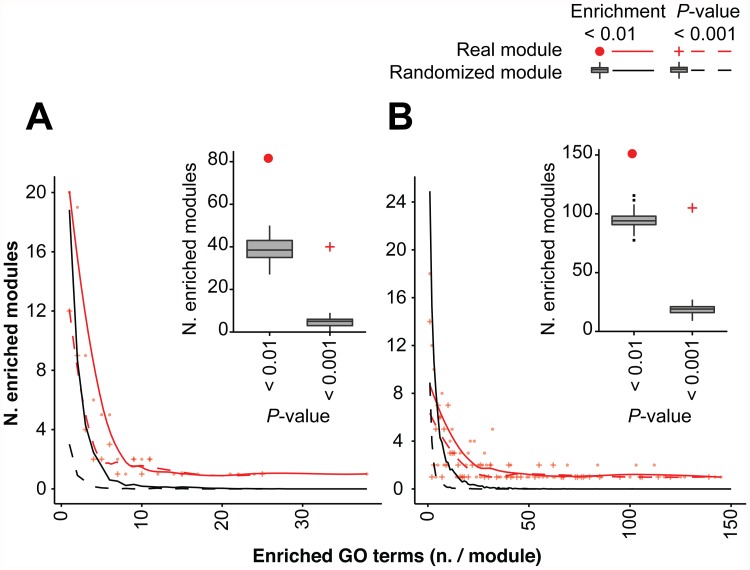
Gene Ontology (GO) term enrichments in modules identified by WGCNA and in randomly generated modules.(A) Molecular function and (B) biological process GO terms. Line plots represent the number of enriched modules as a function of the number of enriched terms in a module. Red symbols represent the observed counts, and red lines represent the best smooth of the data points. The black lines and symbols represent the mean number of enriched modules for modules with any given number of enriched GO terms in 100 random replicates. The boxplot represents the number of total modules with at least one enriched term in all 100 random permutations of the network. Red symbols represent the number of modules with at least one enriched term in the natural network. Real BP data included eight modules enriched for up to 274 terms, which were not shown in the figure.